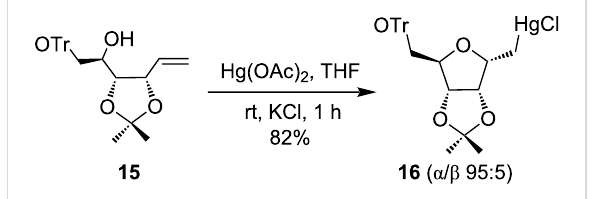
Scheme 7: Hg(OAc) 2 -mediated synthesis of α - ᴅ -ribose derivative.